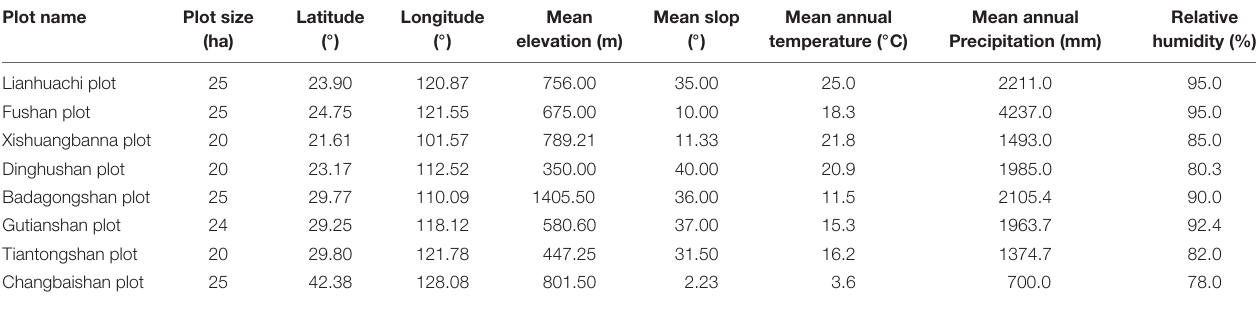
TABLE 1 | Information on geography and climate for eight study